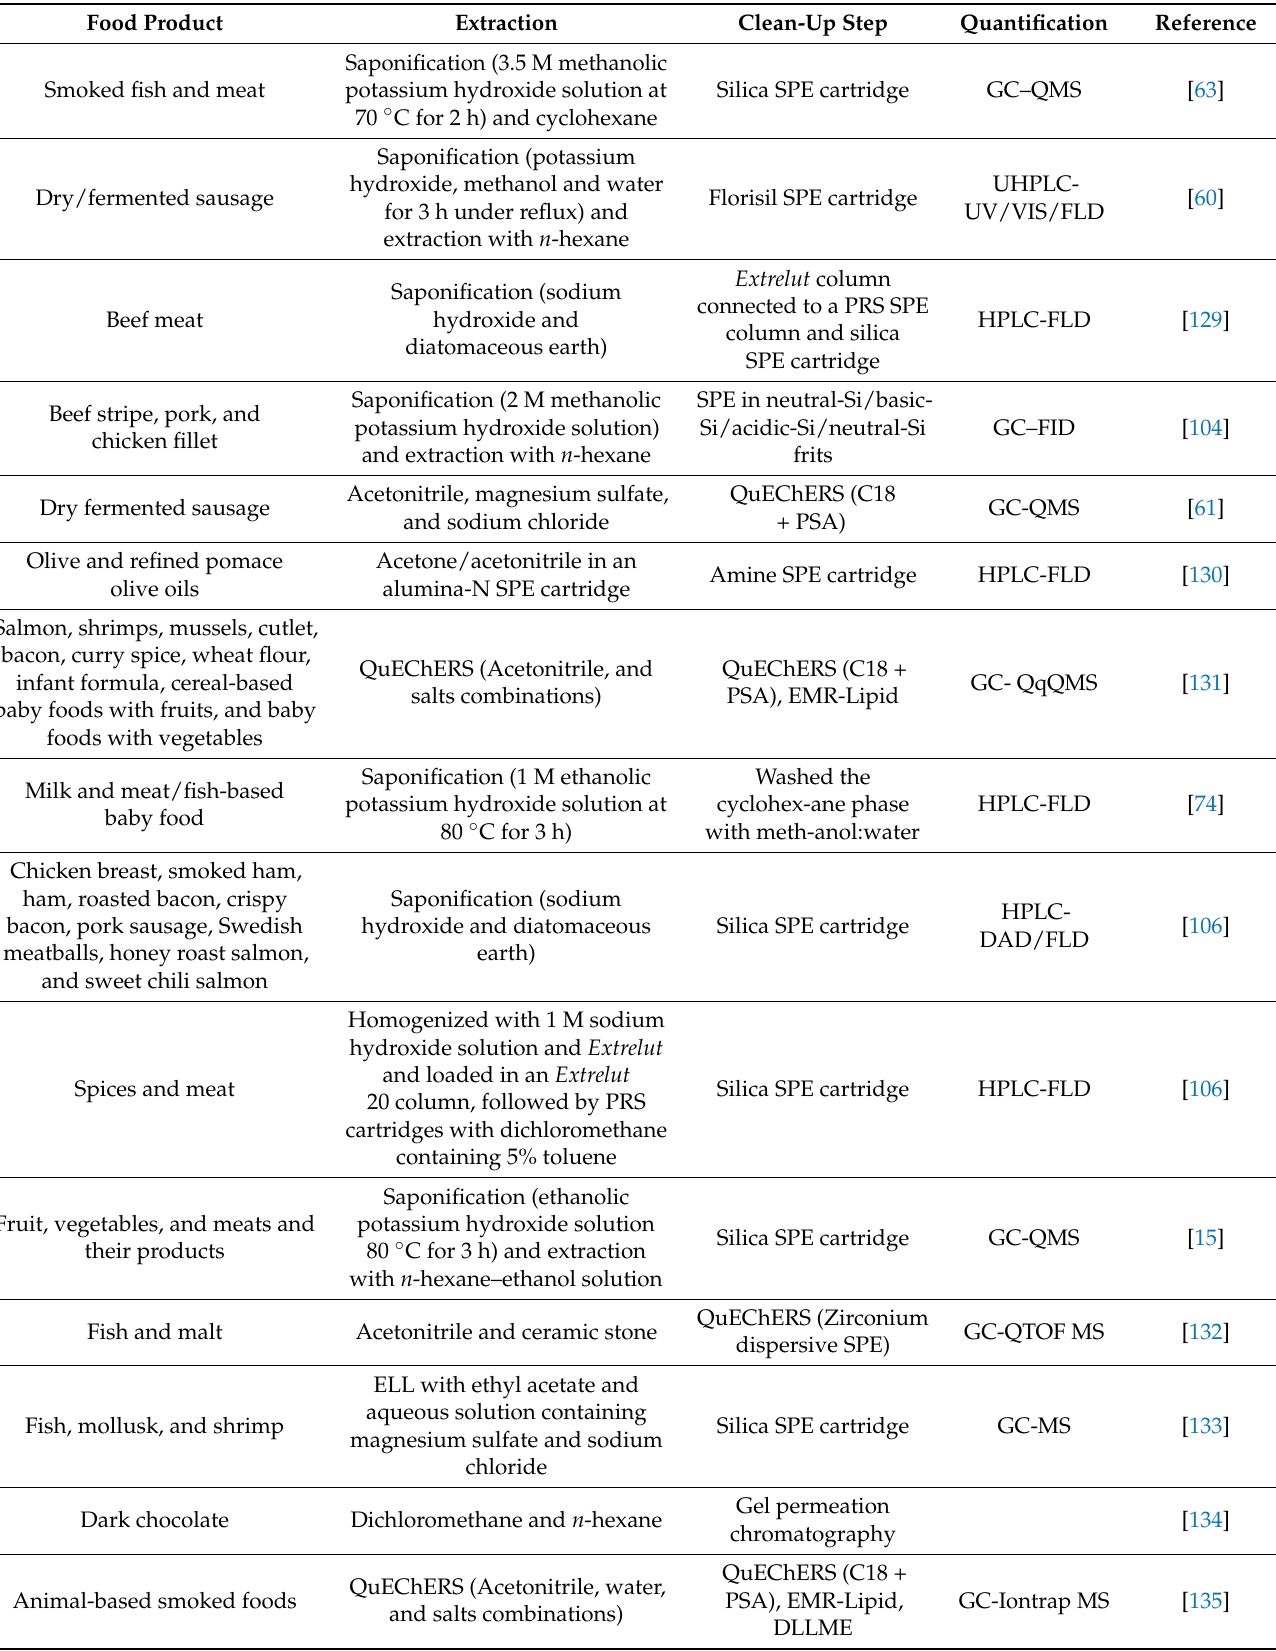
Table 5. Recent techniques for the determination of polycyclic aromatic hydrocarbons in food